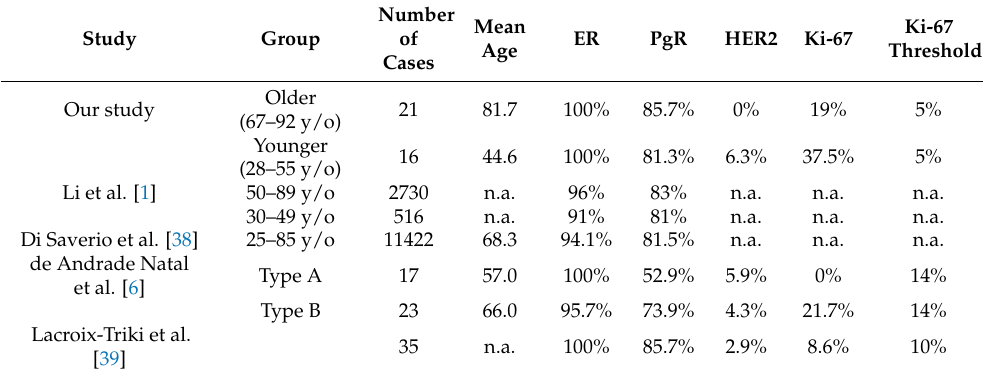
Table 6. Reported immunohistochemical property of breast mucinous